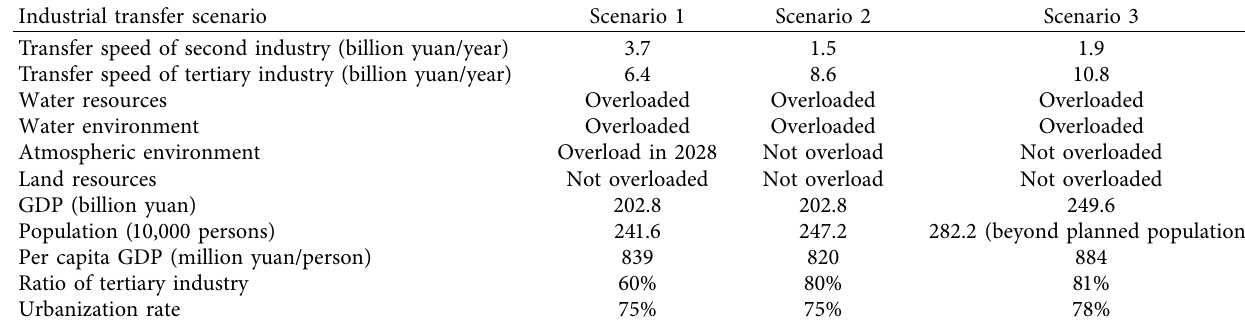
Figure 3: Xiong’an model (XAM). Table 1: Simulation results by